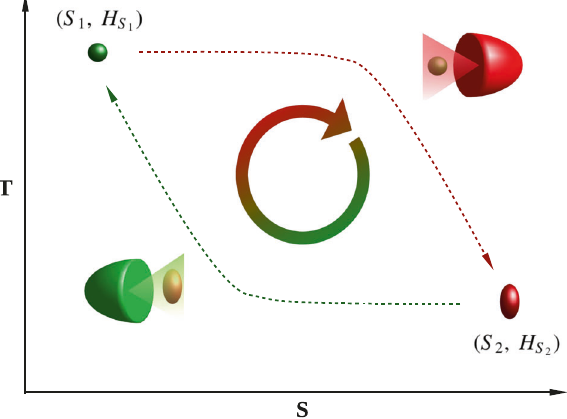
Fig. 2 Generalized one-step engine operation. Consider initial state and the non-interacting Hamiltonian of the working system are ρ S 12 and H ¼ H þ H S 12 S 1 S 2 , respectively. The sub-systems S 1 and S 2 semi- locally interact with the baths B 1 and B 2 with inverse temperatures β